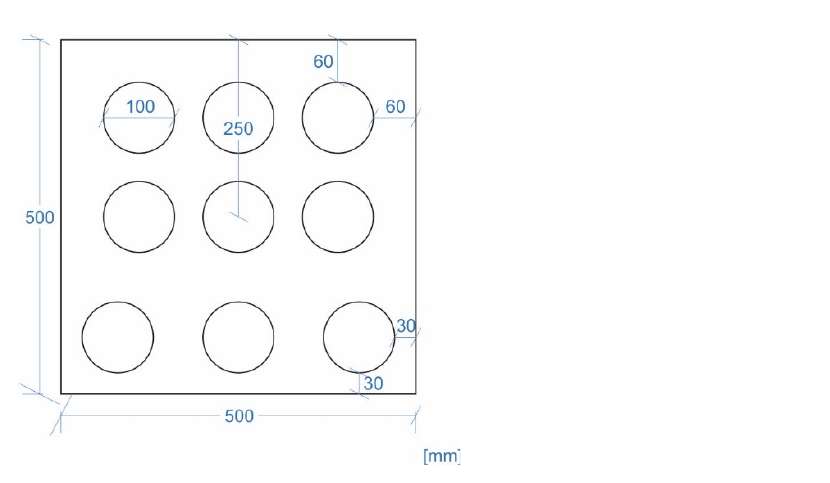
Figure 1. Schematic figure of the arrangement of the drilling cores in the concrete plates.